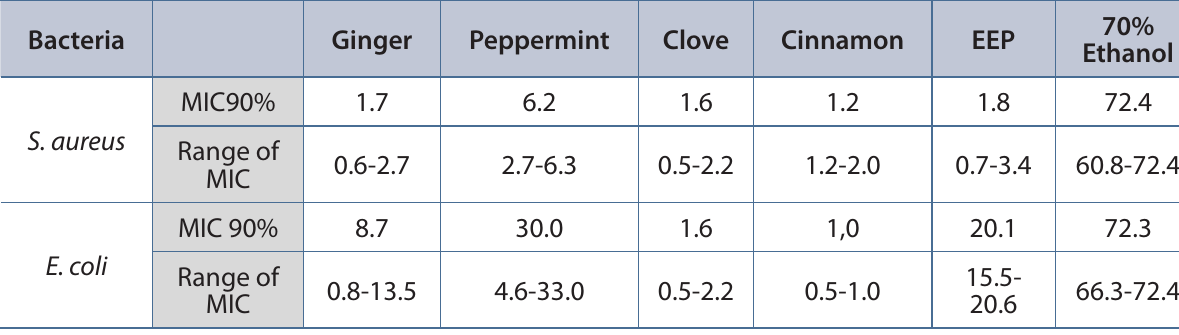
Table 3. MIC and range of MIC values (mg x mL –1 ) of EO, EEP and 70% ethanol against 16 S. aureus and 90% 16 E. coli strains